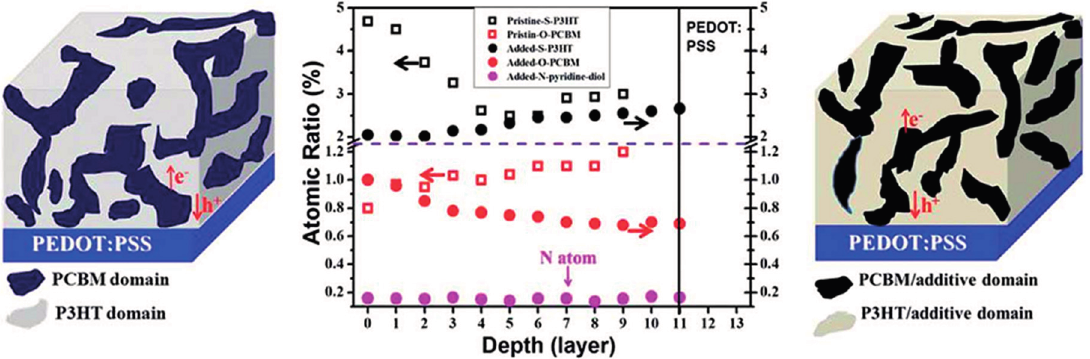
Figure 13. XPS Depth profile analysis of unannealed P3HT:PCBM films with and without additive. Reproduced from [152] with permission from The Royal Society of